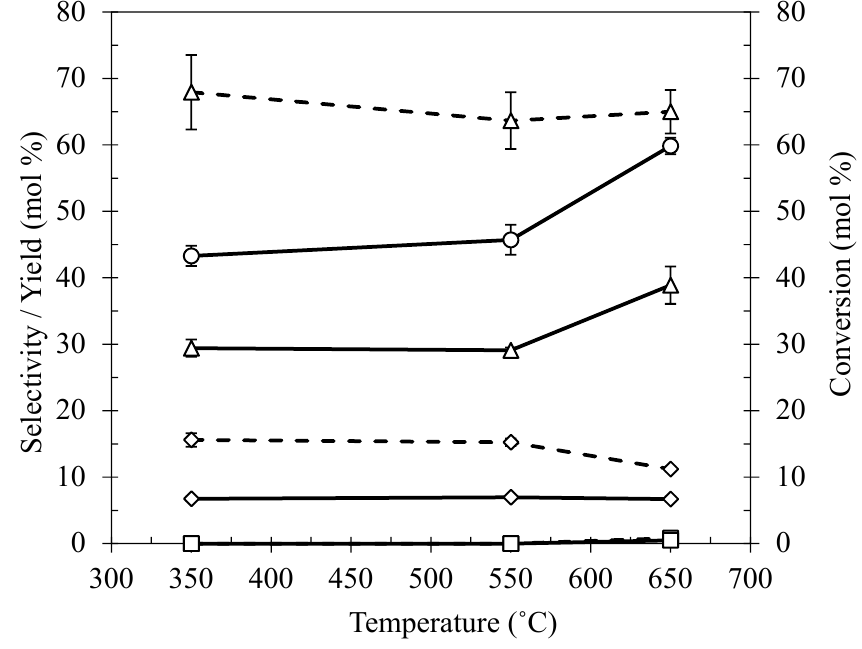
Figure 3. Effect of calcination temperature on the activity of 25 wt % Ni/Ce–Mg (9:1) catalysts prepared by DP. Reaction conditions: reactant 100 g (60 wt % glycerol in H 2 O), 10 g catalyst, hydrogen initial pressure pH 2 = 6.9 MPa, reaction temperature T = 215 °C, and reaction time t = 24 h. Legend: solid lines for glycerol conversion and product yields, dashed lines for product selectivity, ( ○ ) glycerol conversion, ( ) ethanol, ( □ ) n -propanol, ( Δ ) 1,2-PDO. Error bars are based on the average values of duplicate experimental data.